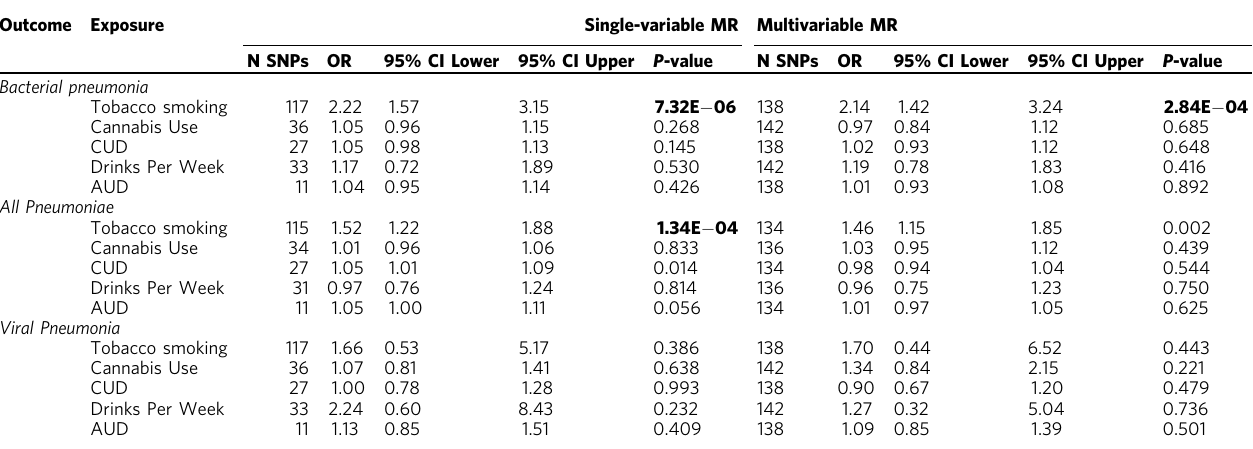
Table 5 Single variable and multivariable MR results of the genetic liability of alcohol, cannabis and lifetime smoking exposures on pneumonia risk. Outcome Exposure Single-variable MR Multivariable MR